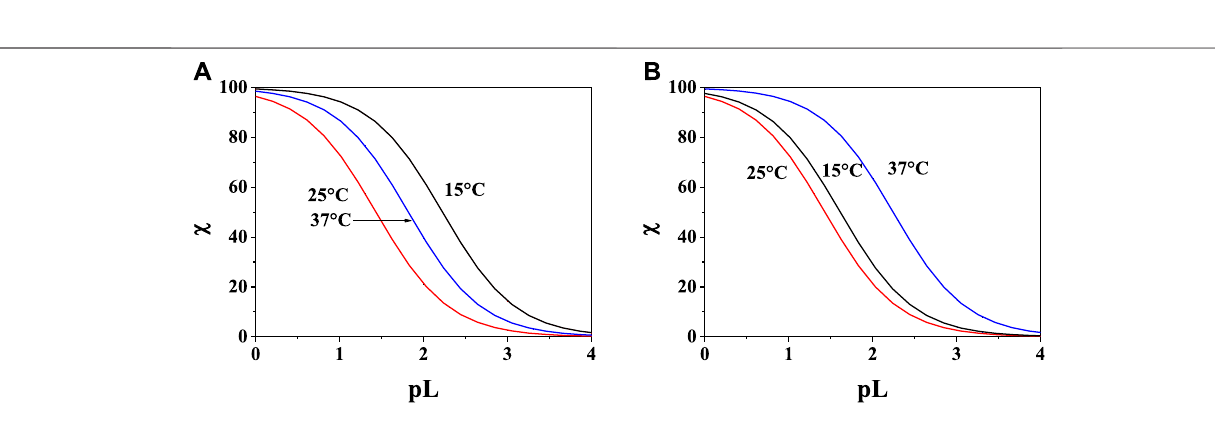
Frontiers in Chemistry |